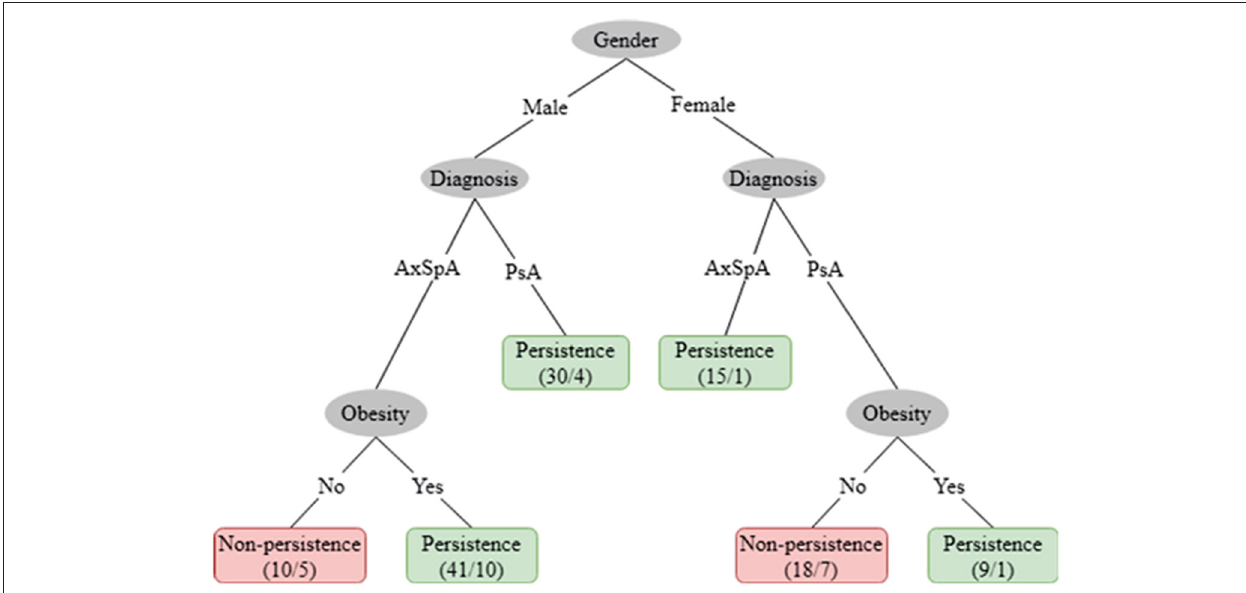
FIGURE 2 | Decision tree J48. The figures in the boxes represent the number of patients that the algorithm included in each branch, divided by the number of patients that the algorithm did not correctly predict persistence (green boxes) or non-persistence (red boxes) after 1 year of treatment.